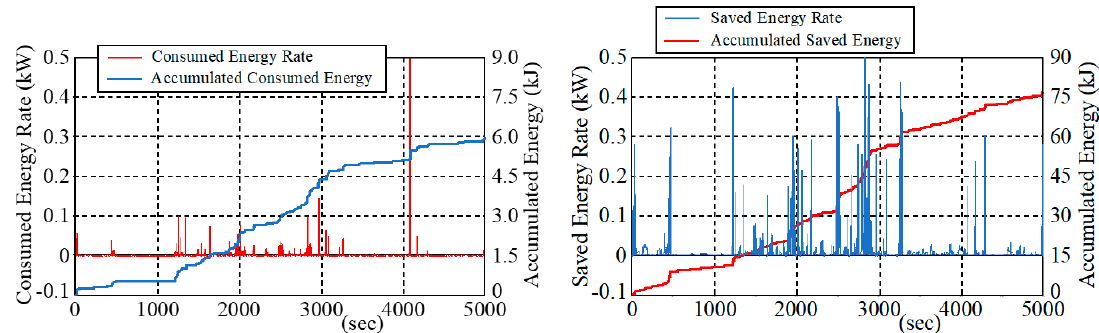
Figure 36. Consumed and saved energy on AMS evaluation course.